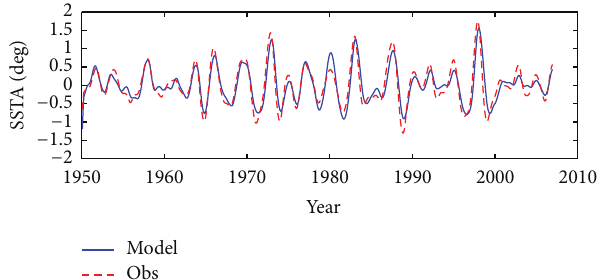
Figure 4: The bandpass filtered observed (dashed) and HYCOM-simulated SST anomalies (solid) in Nino3.4 region from 1950 to 2006.